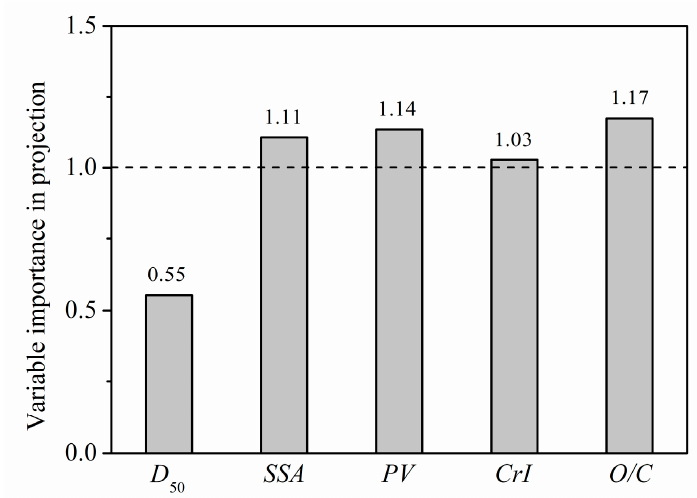
Figure 12. VIP scores of microstructure-property modifications for the PLS model.